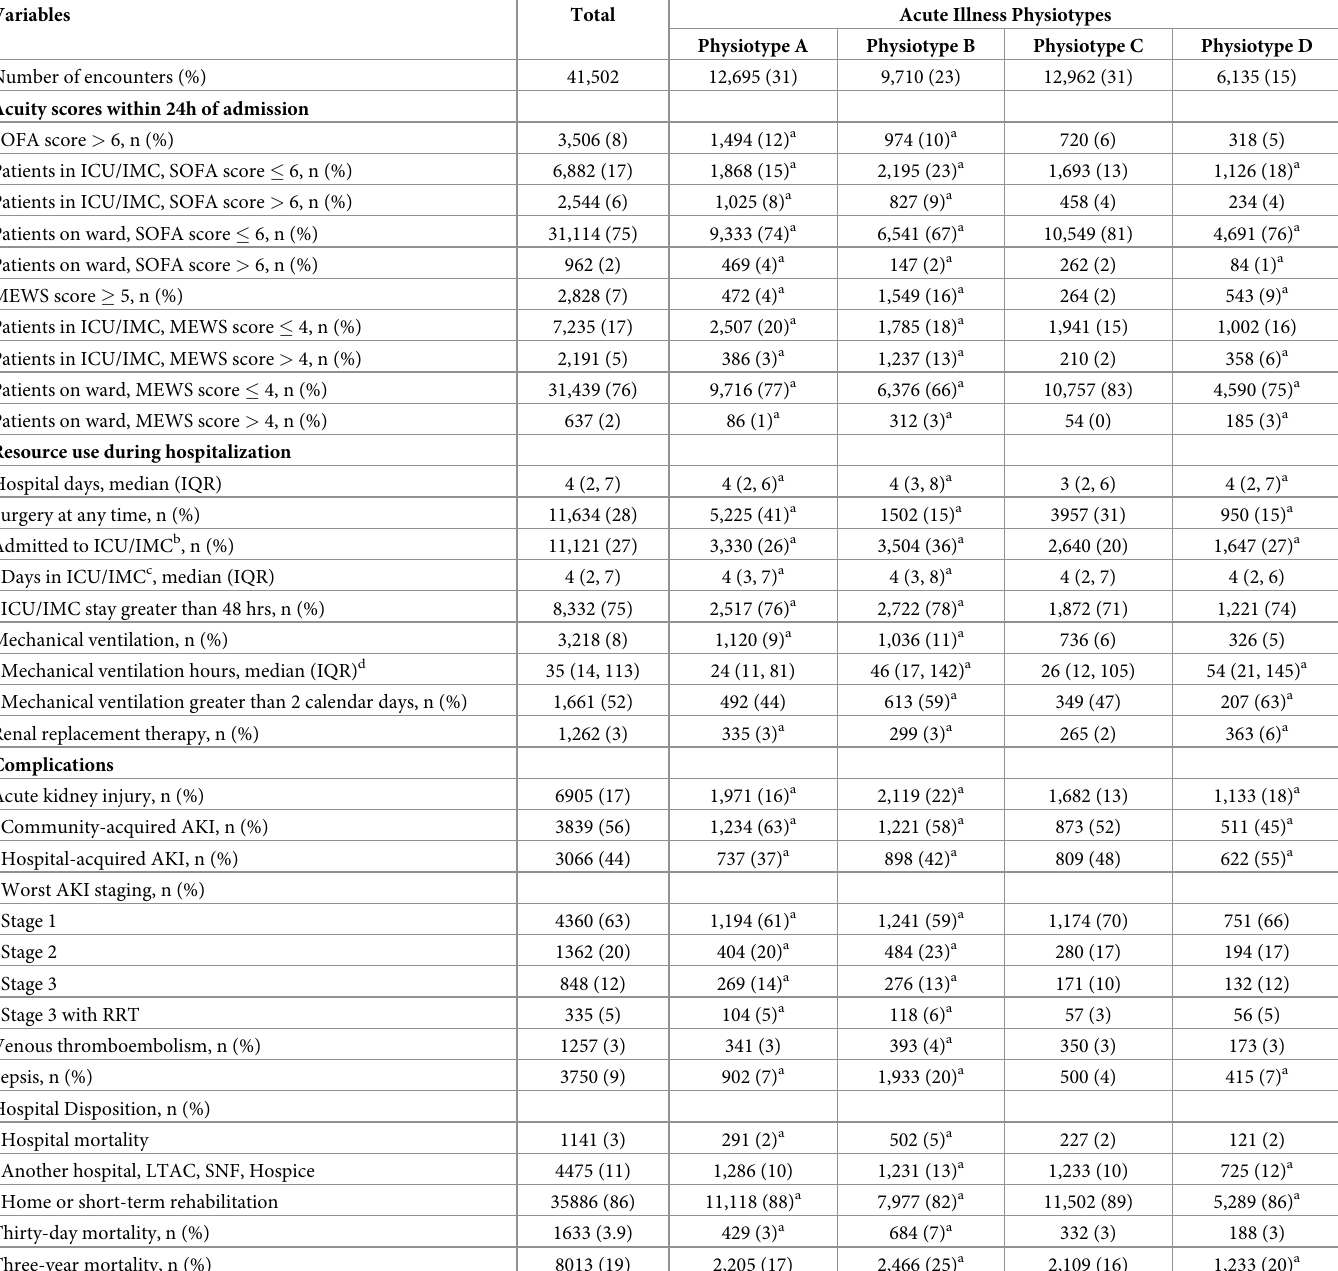
Table 2. Physiotype illness severity, clinical outcomes, and resource